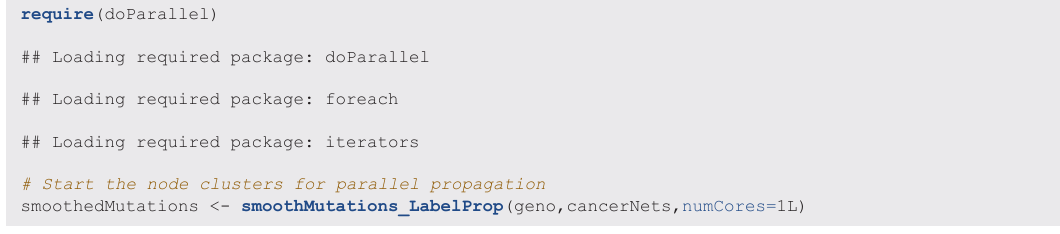
proximity of the non-zero values to the original